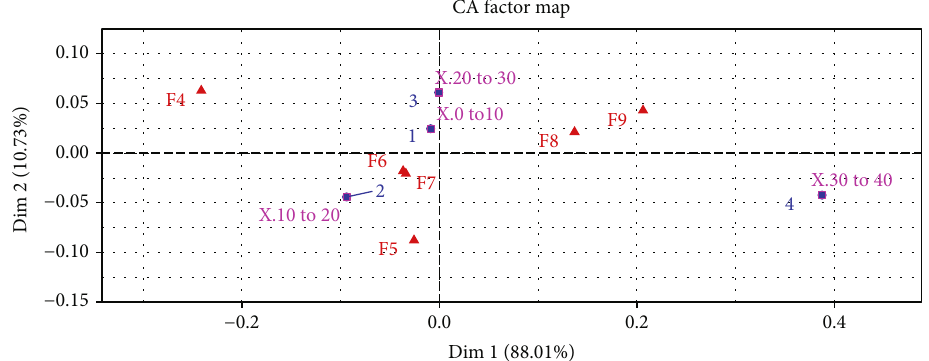
Figure 1: Graph showing the association between the frequency of feeding (F4, F5, F6, F7, F8, and F9) and the occurrence of muscle fi bers in di ff erent classes (0-10, 10-20, 20-30, and 30-40 μ m). F4: 4 times daily; F5: 5 times daily; F6: 6 times daily; F7: 7 times daily; F8: 8 times daily; F9: 9 times daily; Dim 1: dimension 1; Dim 2: dimension 2; X.0 to 10: fi ber between 0 and 10 micrometers; X.10 to 20: fi bers between 10 and 20; X.20 to 30: fi bers between 20 and 30 micrometers; X.30 to 40: fi bers between 30 and 40 micrometers. Table 6: Mean values ± standard deviation of hepatocyte area ( μ m 2 ) and nuclear area ( μ m 2 ) in hepatocytes of Nile tilapia fi ngerlings ( Oreochromis niloticus ) in the di ff erent treatments. Feeding frequency